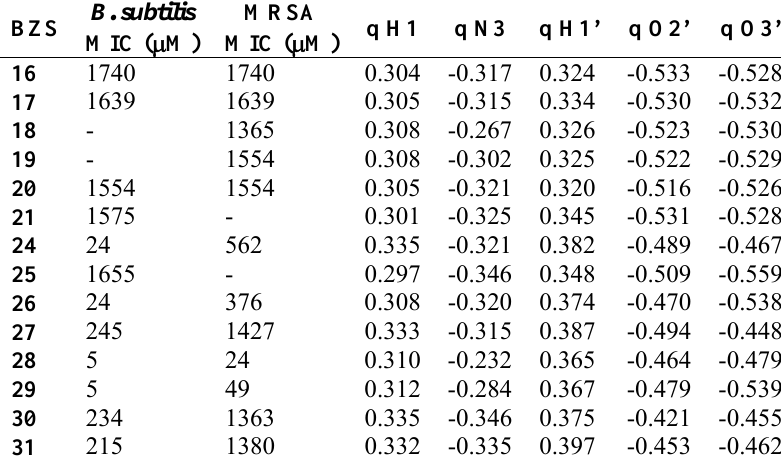
Table 4. Correlation coefficients (r) for the linear regression analysis of atomic charges with antimicrobial activity of BZS derivatives. -log MIC = a + bq